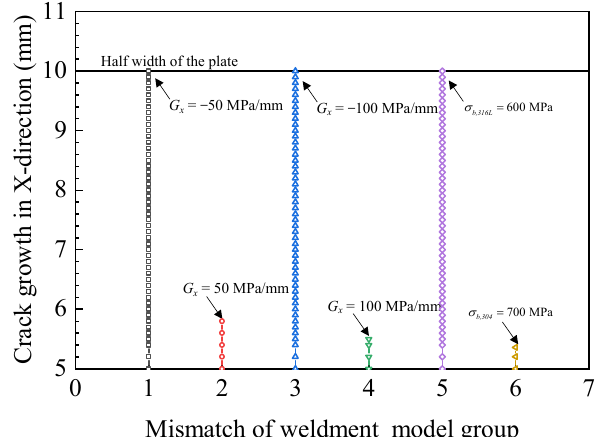
Figure 10. Crack propagation lengths of different ultimate strength mismatch coefficients in the x ‐ direction.